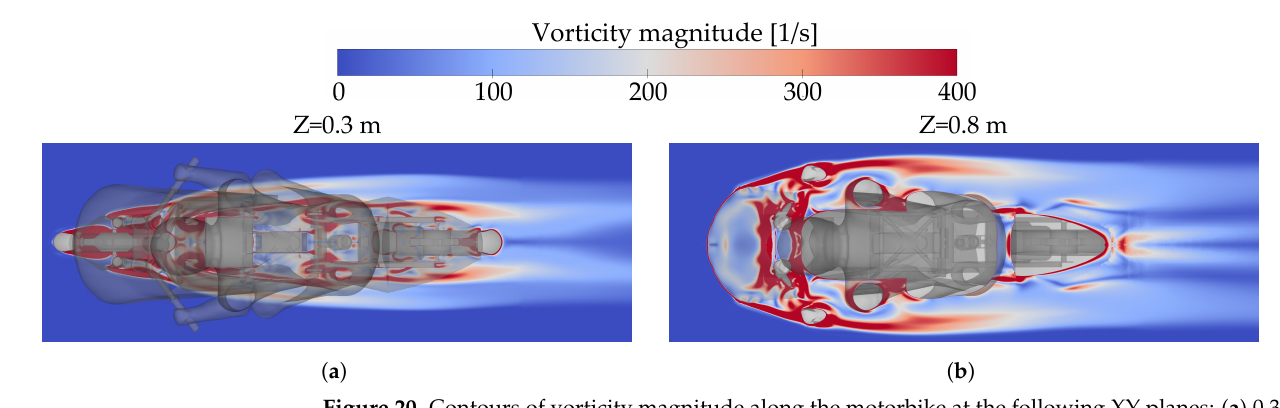
Figure 20. Contours of vorticity magnitude along the motorbike at the following XY planes: ( a ) 0.3 m in Z direction and ( b ) 0.8 m in Z direction.